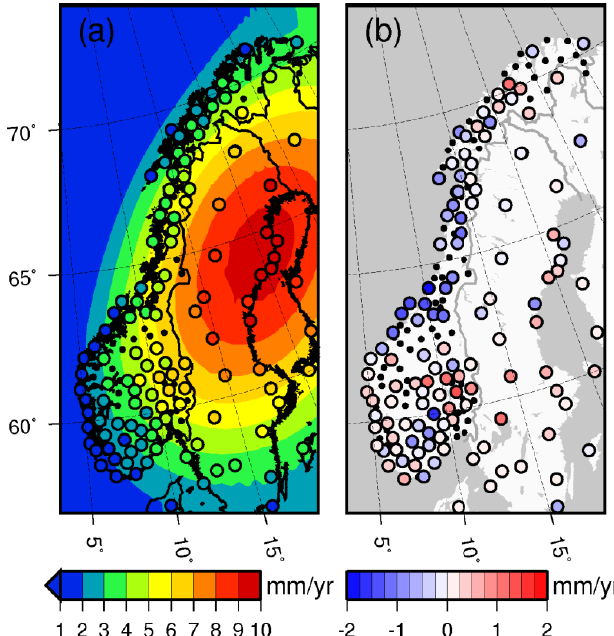
Figure 5. ( a ) Modelled vertical land motion from the best-fit GIA model. The vertical velocities from the GPS observations are shown as circles. Black dots mark stations with less than three years of data, these observations are not included in this study as they are considered unreliable. ( b ) Residuals (observed minus modelled).